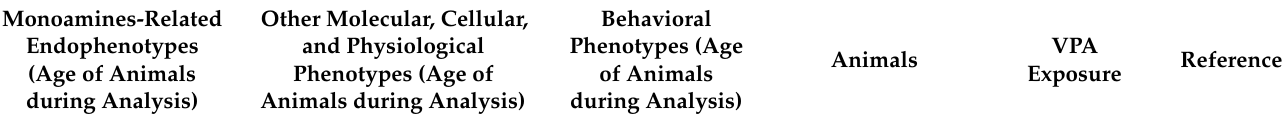
Table 2. Summary of valproic acid (VPA)-induced teratogenicity in catecholaminergic and histamin- ergic